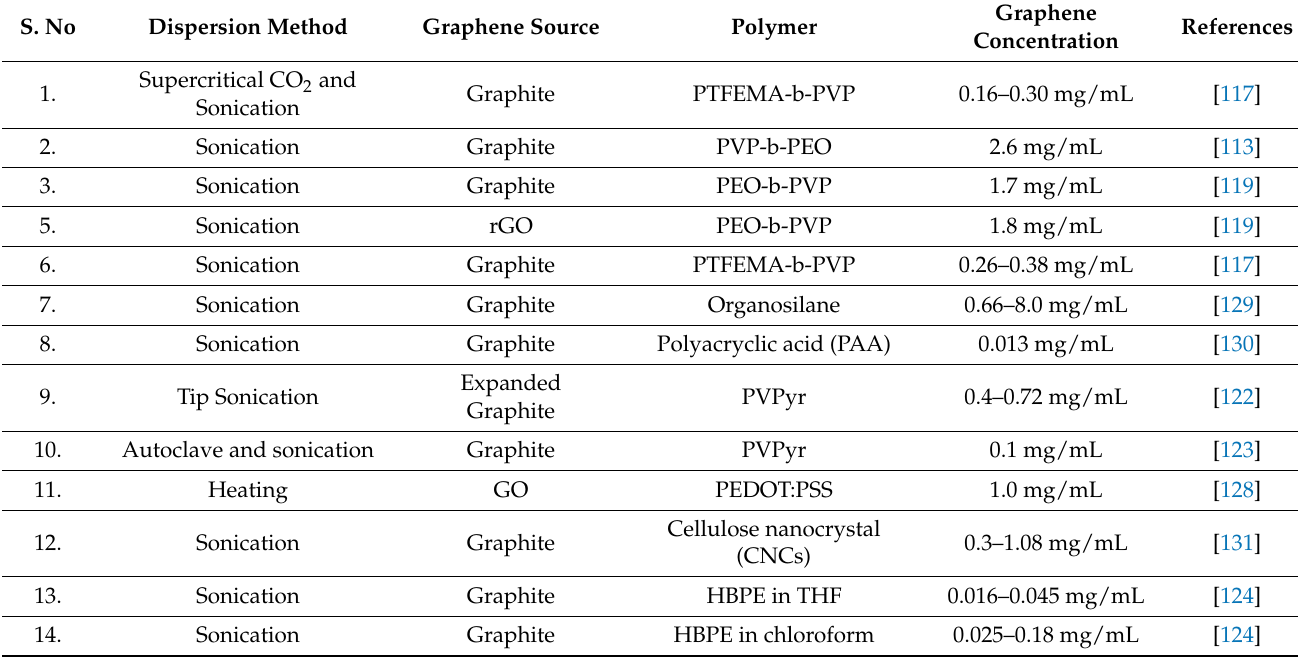
Table 3. A comparison table showing dispersion methods, graphene sources, polymers, and graphene concentration values. S.